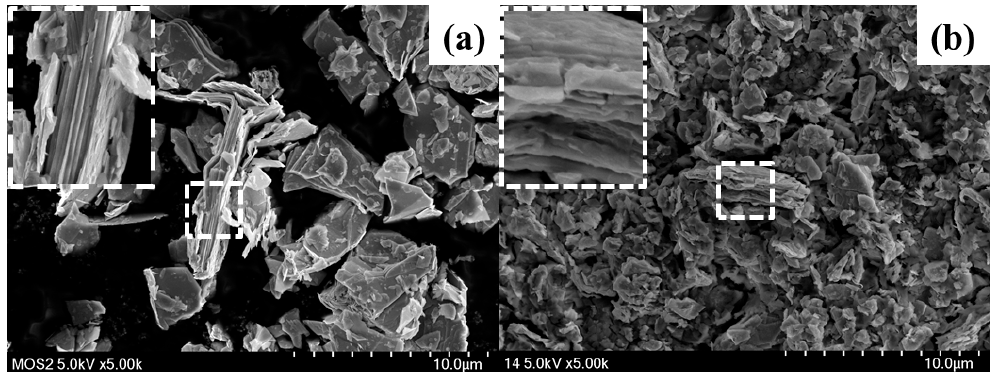
Figure 1. SEM images of ( a ) MoS 2 and ( b ) Ziegler–Natta catalyst intercalated MoS 2 .